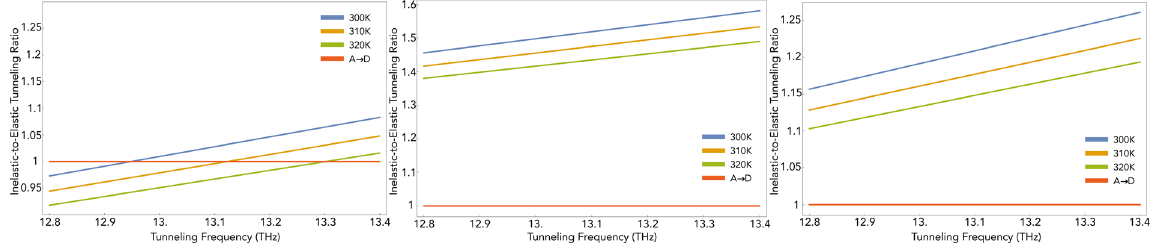
Figure 5. The inelastic-to-elastic ratio versus the tunneling frequency ω x at temperatures T = 300 K, 310 K, and 320 K for transitions (Left) L → E 2 , (Middle) R → E 2 , and (Right) E 1 → E 2 . All figures are plotted at ω z = 10 12 Hz.